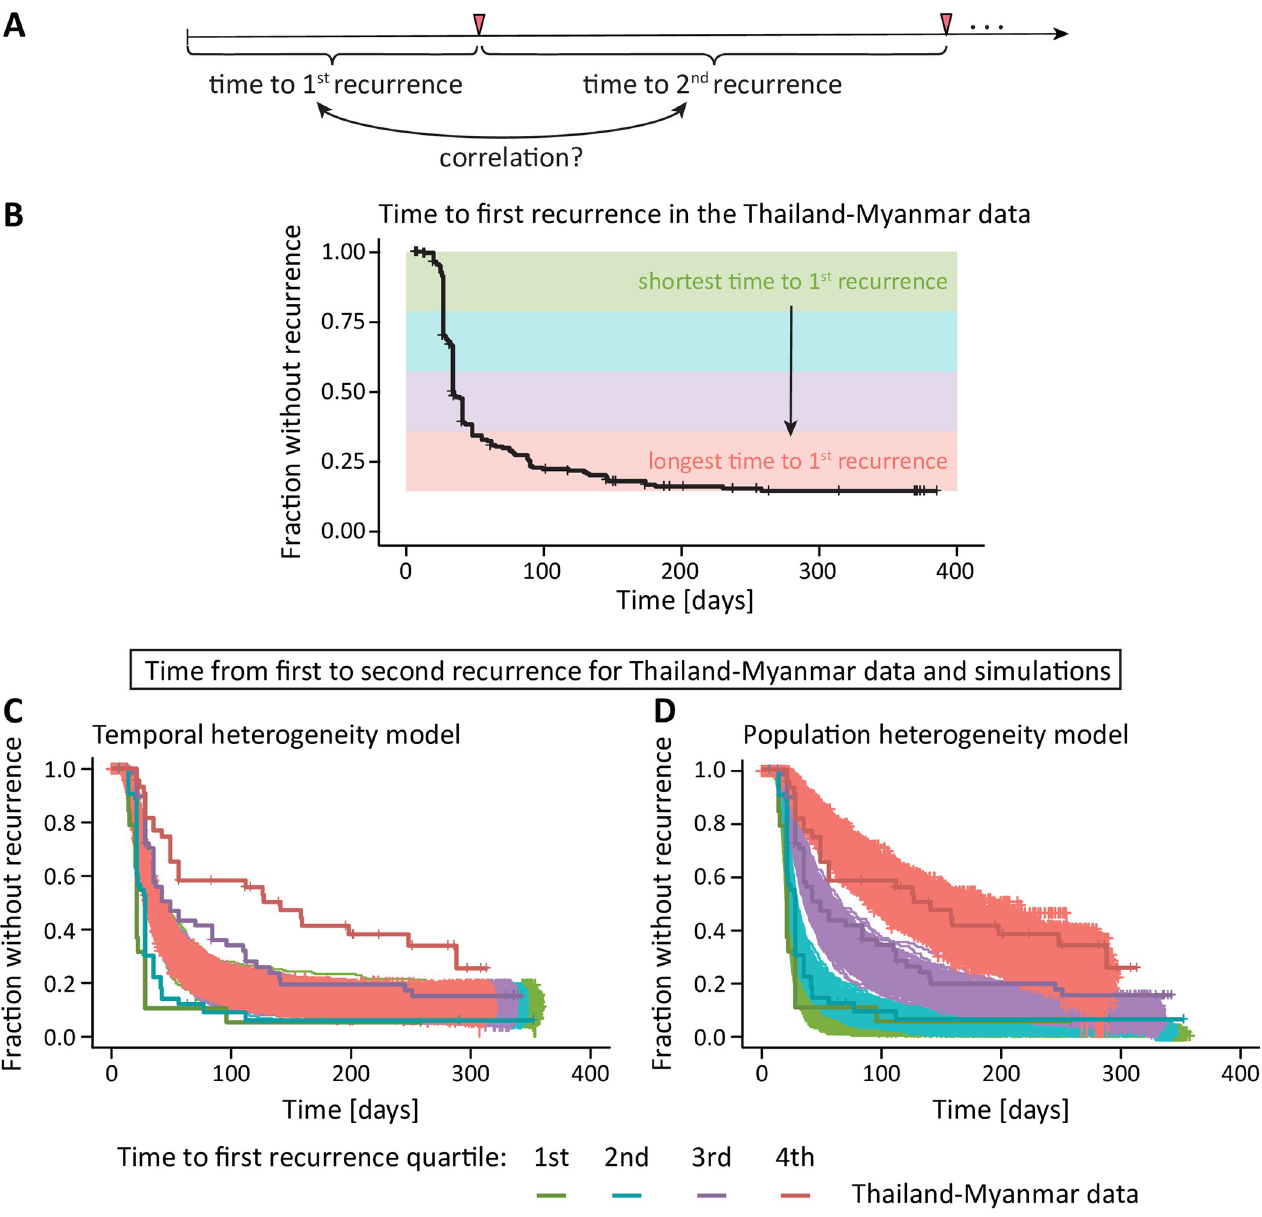
Fig 4. Association between different recurrence times. ( A ) Since we have multiple within patient recurrence times in the Thailand-Myanmar data, we can estimate the correlation between the time to first recurrence and the time to the second recurrence. ( B ) All individuals in the Thailand-Myanmar data who were treated with artesunate are grouped by their time to first recurrence quartiles, from shortest (green) to longest (red). ( C , D ) As the recurrence times are correlated, we find that individuals with a shorter time to the first recurrence (green) also have a shorter time from first to second recurrence (the data are shown in bolder lines and darker colors). ( C ) The temporal heterogeneity model cannot capture this feature in the data. The simulations show that all individuals have a similar time from first to second recurrence, regardless of the time to the first recurrence (simulated data are shown in thinner lines and lighter colors). ( D ) In the data simulated under the population heterogeneity model, however, the first recurrence time is predictive of the second recurrence time and this correlation agrees well with the data. The simulated data for chloroquine treatment compared with the Thailand-Myanmar data are shown in Fig L in S1